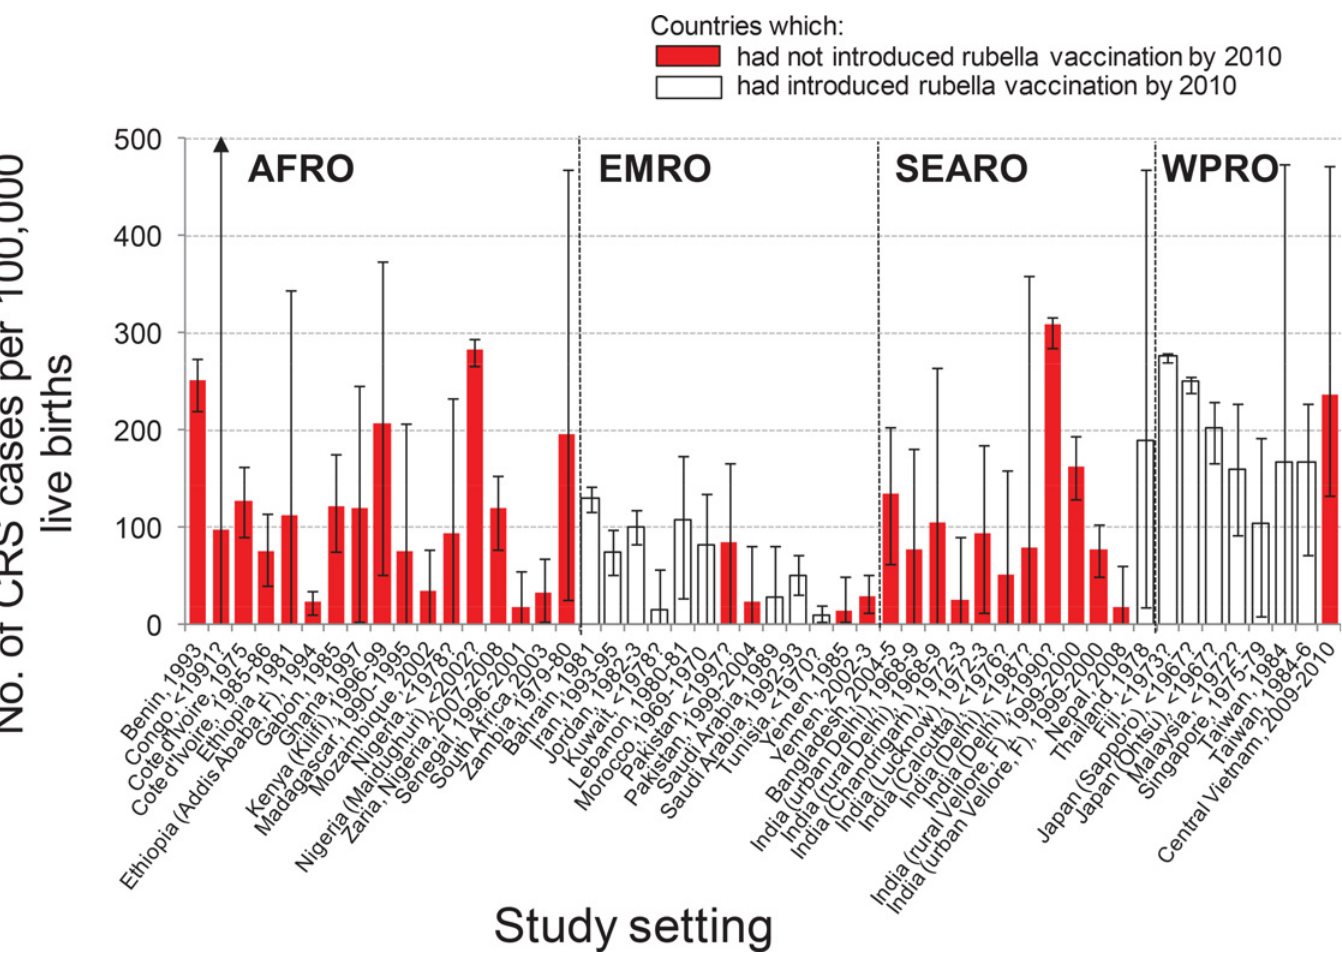
Fig 3. Estimates of the number of CRS cases per 100,000 live births among women aged 15 – 44 years obtained using datasets from countries in which RCV had not been introduced at the time of collection. The red bars reflect countries which had not introduced RCV by 2010; the white bars indicate countries which had introduced RCV by 2010. The estimates have been weighted by the number of live births in the corresponding country in 2010. Labels on the x-axis denote the year of data collection; uncertain dates of collection are indicated using a question mark. The countries are grouped by WHO regions (AFRO = African, EMRO = Eastern Mediterranean, SEARO = South East Asian, WPRO = Western Pacific).